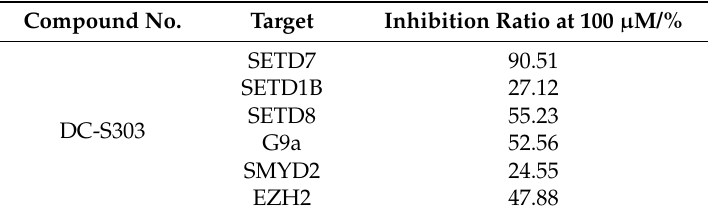
Table 3. Selectivity of DC-S303 over other epigenetic targets.